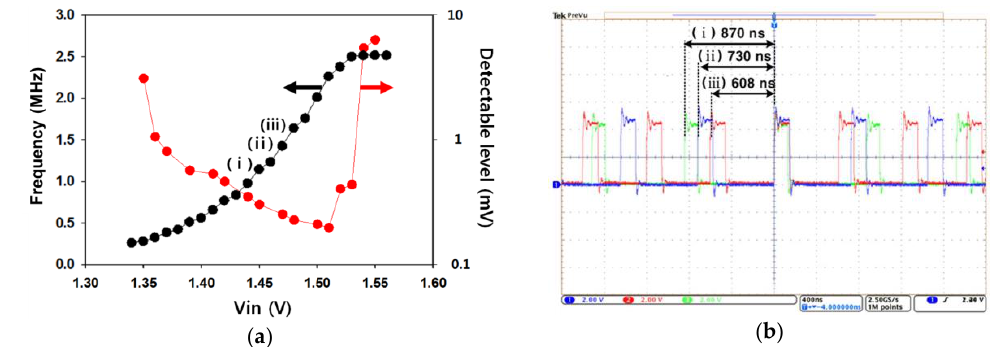
Figure 4. ( a ) Oscillation frequency of the ring oscillator and detection resolution for the surface